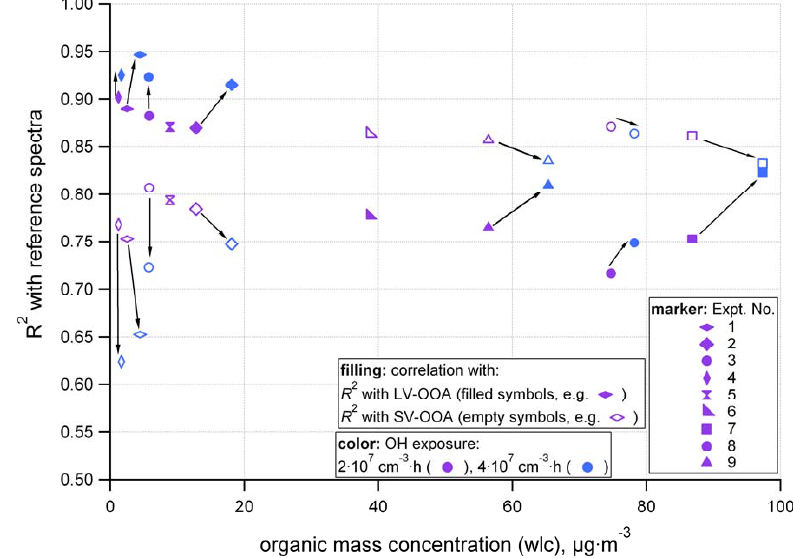
Fig. 4. Squares of the Pearson correlation coefficients, R 2 , of measured mass spectra in comparison with LV-OOA (filled symbols) and SV- OOA (empty symbols) reference spectra as a function of the organic mass concentration (wlc). The color code represents the OH exposure at the midpoint of a 30-min mass spectral average. The corresponding mass spectra are shown in Fig. S10 in the Supplement. Table 4. The OH exposure required to increase the O:C ratio above 0.6 at the corresponding organic mass concentration org (wlc). For experiments that do not exceed the threshold of 0.6, the OH ex- posures are extrapolated and the maximum measured org (wlc) is given, both indicated by the asterisk. Expt.